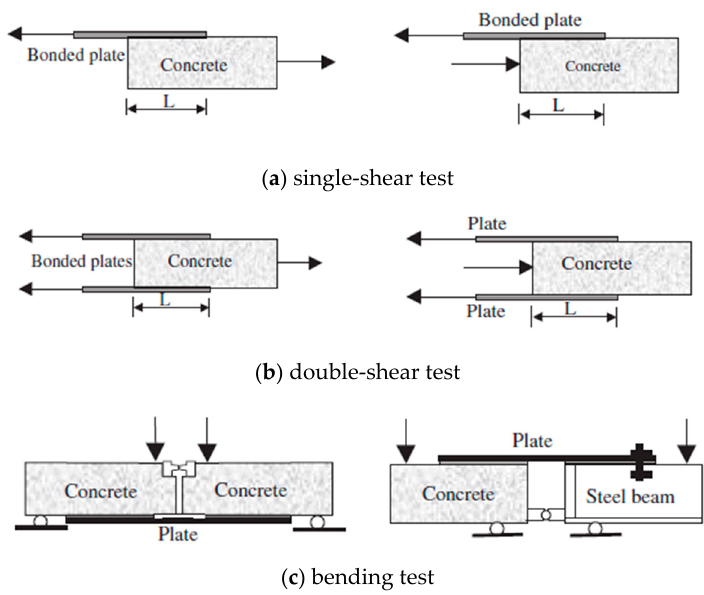
Figure 1. Three types of bond tests: ( a ) single-shear test; ( b ) double-shear test; and ( c ) bending test.